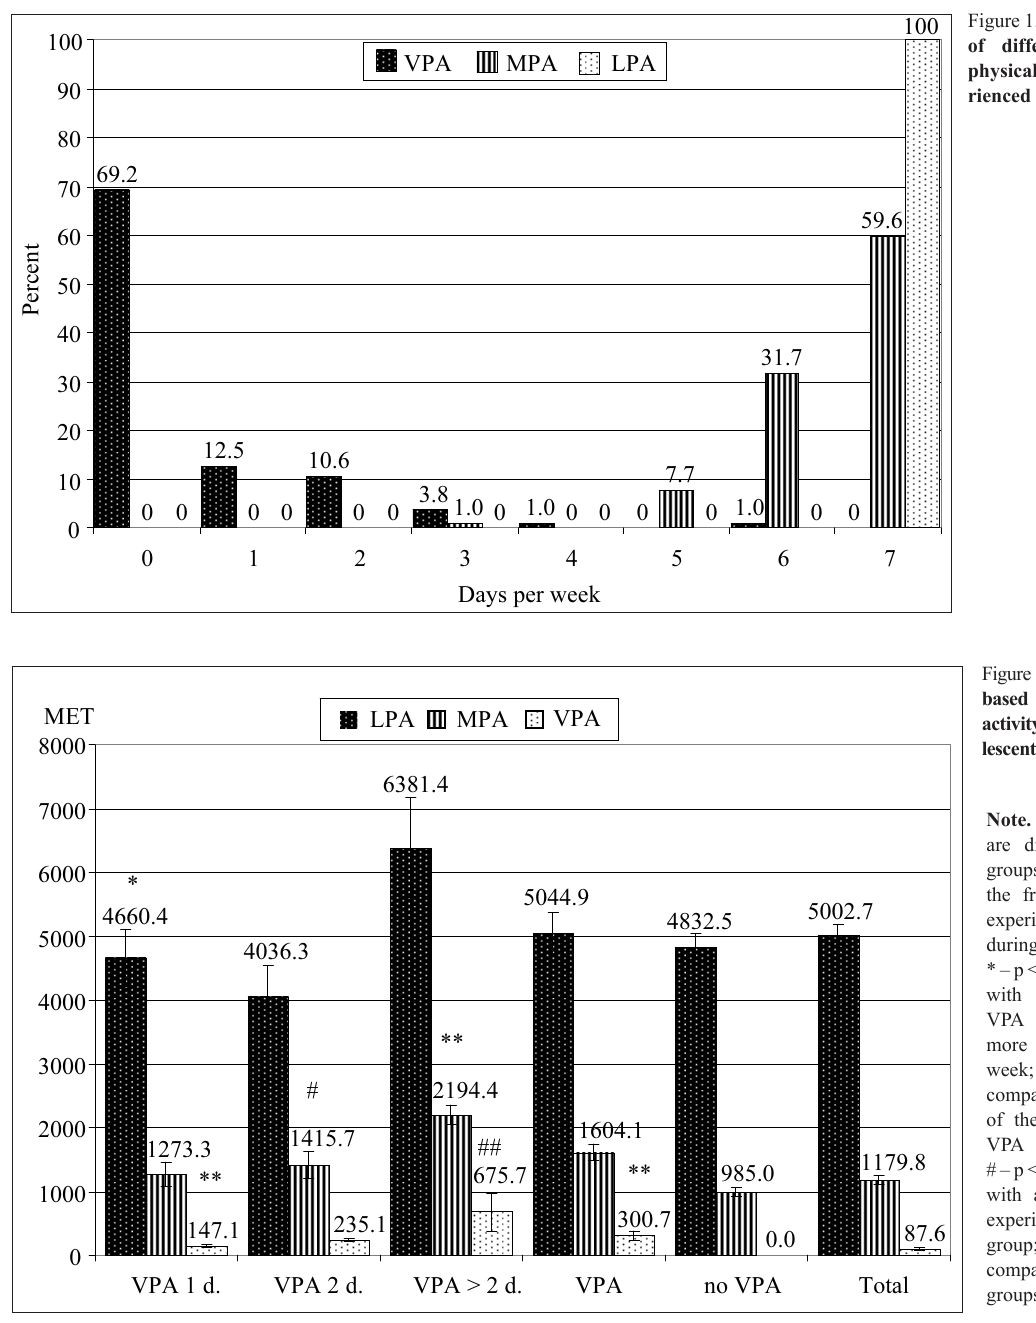
Figure 2. The intensity-based weekly physical activity of the adolescent boys